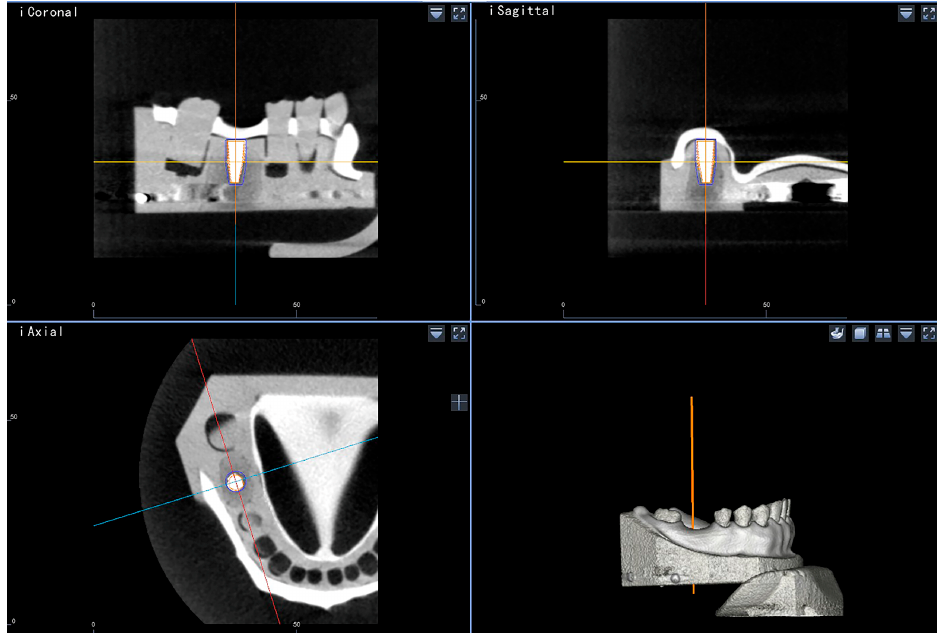
Figure 6. The achieved three-dimensional images of the virtual implant, which represented the actual implant in the dynamic navigation software. Postoperatively, a radiological assessment of the inserted implants was performed using CBCT. The settings were consistent with those of the preoperative scans. The